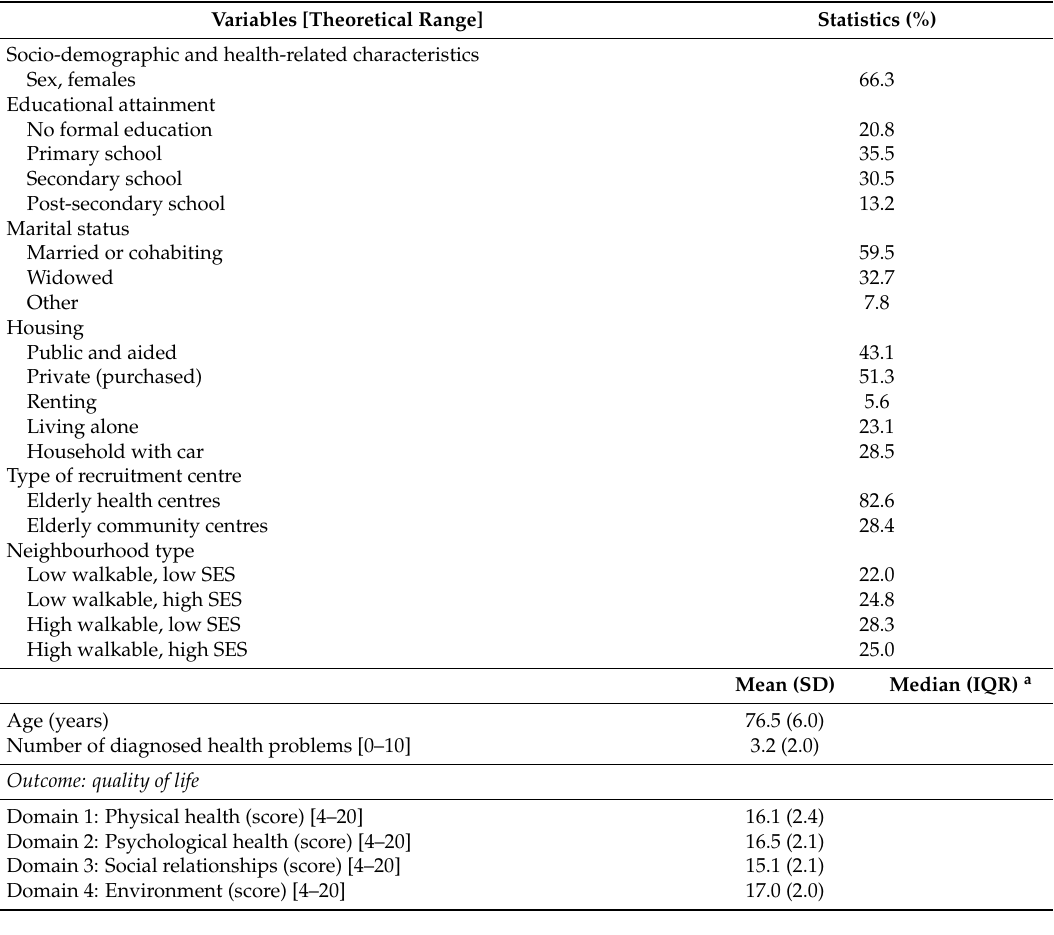
Table 1. Sample characteristics ( N =